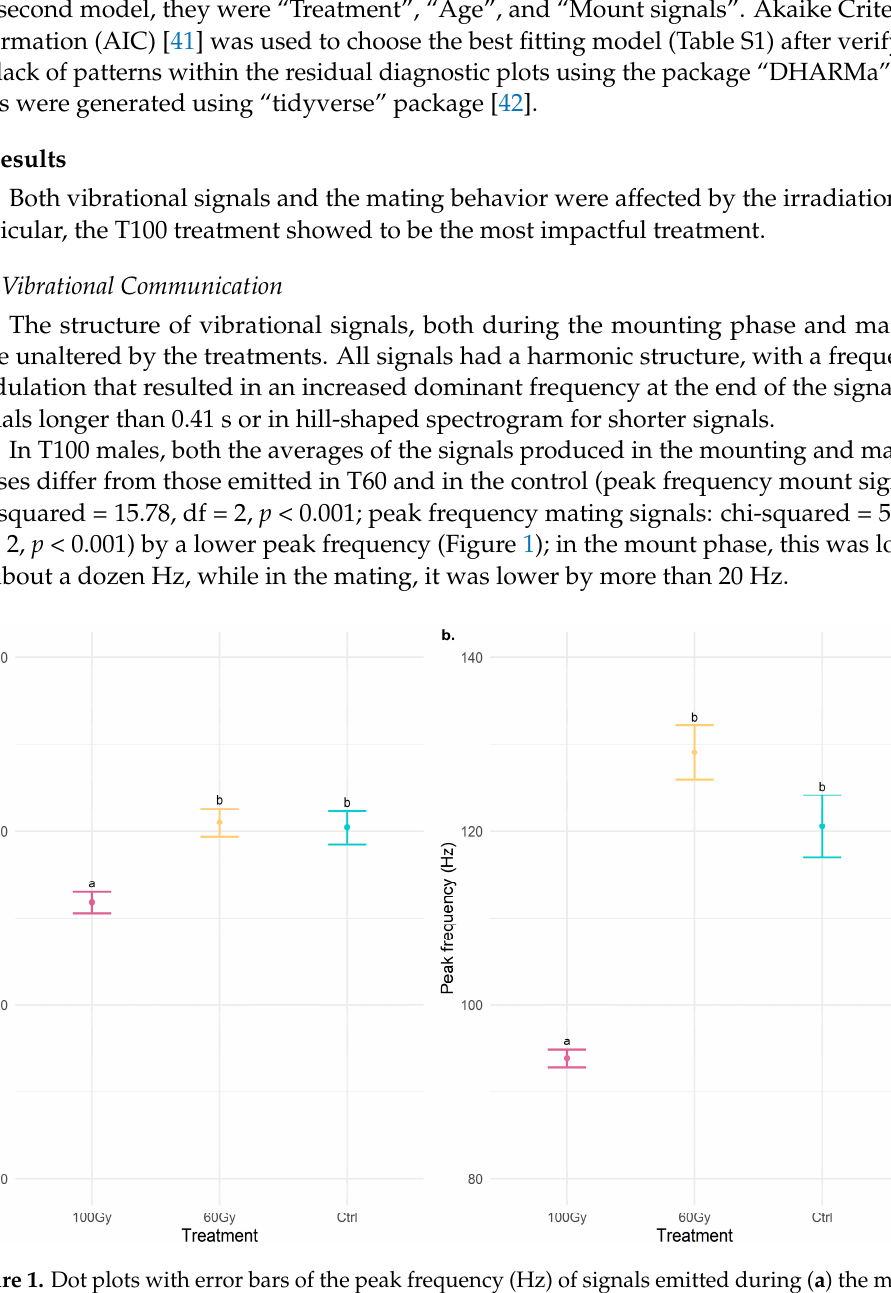
Figure 2. Dot plots with error bars of the delta time (s) of signals emi tt ed during ( a ) the mounting phase and ( b ) mating. The dot represents the mean of delta time, and the error bar represents the standard error of the mean.